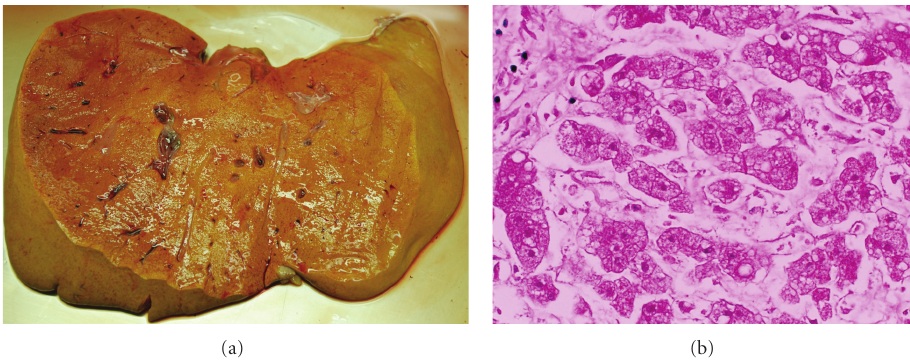
Figure 1: (a) The liver showing yellow steatosis. (b) Microvesicular steatosis in hepatocytes (H&E ×